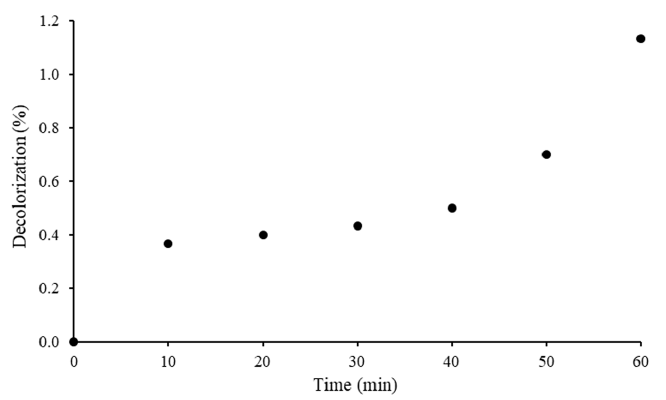
ff ect of initial dye concentration on the % decolorization of 20N–TiO Figure 11. Effect of initial dye concentration on the % decolorization of 20N–TiO 2 -300 °C. Figure 11. E